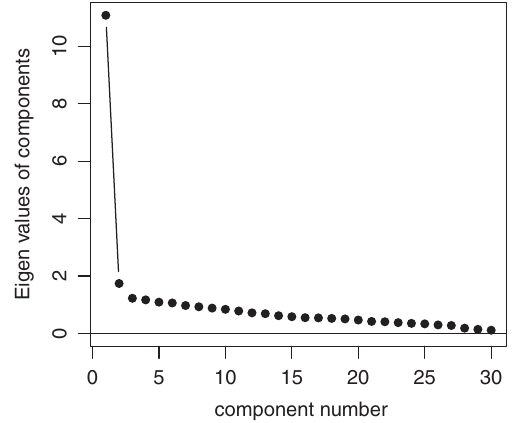
FIG. 2. The scree plot for the tetrachoric correlation matrix via a principal component analysis using the filtered empirical dataset α ( N ¼ 2712